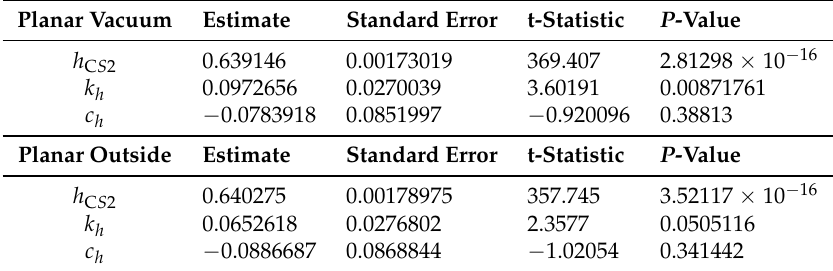
Table 3. The parameters of fitting h S 2 = h C S 2 + k h of the vacuum and the vortex outside. The three parameters are identical within errors for the vacuum and the vortex outside. The positive sign of k h indicates the absence of long range fluctuations of the n-vector.